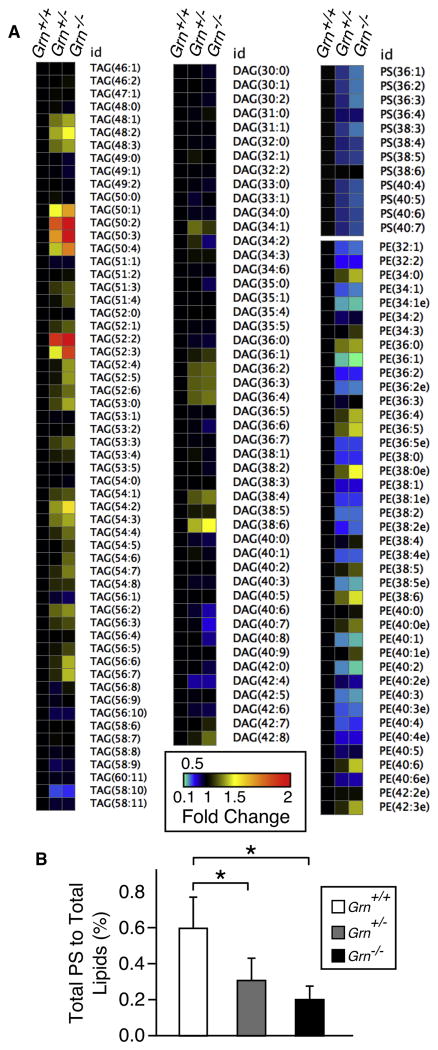
Relative Changes in Individual Lipid Species from Enriched Hepatic Lysosome Fractions between Wild-Type and Grn Mutant Mice(A and B) Lysosomes were enriched from livers of 4-month-old Grn+/+, Grn+/− and Grn−/− mice (n = 3 per genotype), and the extracted lipids were analyzed (TableS2H). (A) Heatmap of individual species of TAGs, DAGs, PSs, and PEs in enriched lysosomes is shown. Data are normalized to Grn+/+ values. (B) Total PS levels relative to total lipid content (%) from enriched hepatic lysosomes isolated in (A) are shown. Data are presented as mean ± SEM; two-tailed Student's t test; *p < 0.05.